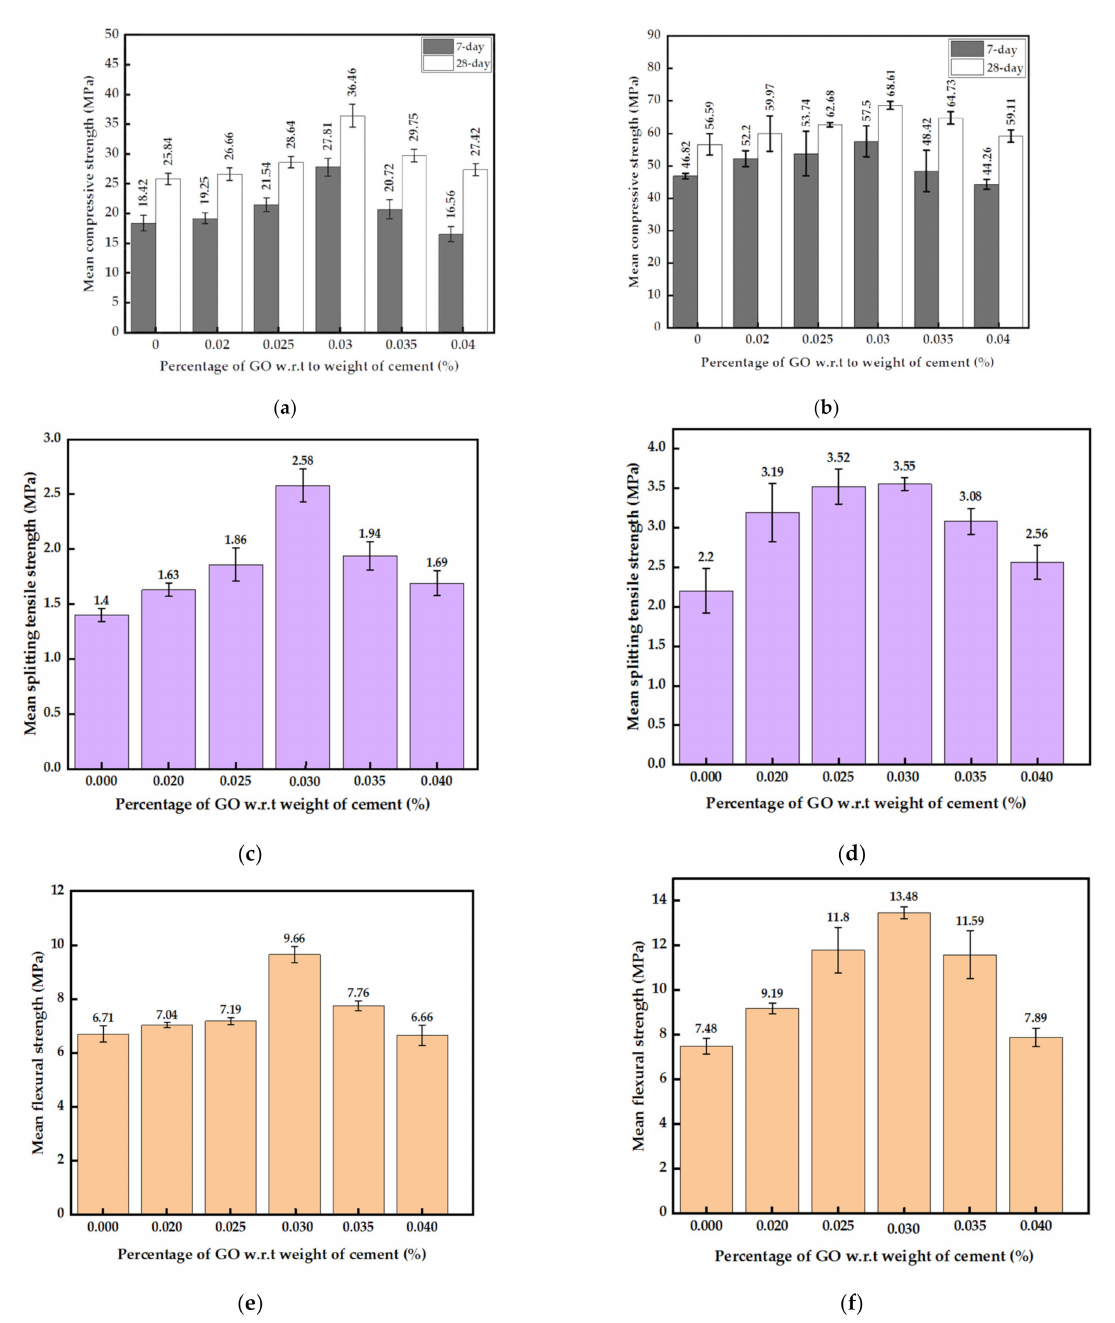
Figure 7. ( a ) 7-day and 28-day compressive strengths of cement mortar with GO paste; ( b ) 7-day and 28-day compressive strengths of cement mortar with GO powder; ( c ) 28-day splitting tensile strengths of cement mortar with GO paste; ( d ) 28-day splitting tensile strengths of cement mortar with GO powder; ( e ) 28-day flexural strengths of cement mortar with GO paste; ( f ) 28-day flexural strengths of cement mortar with GO